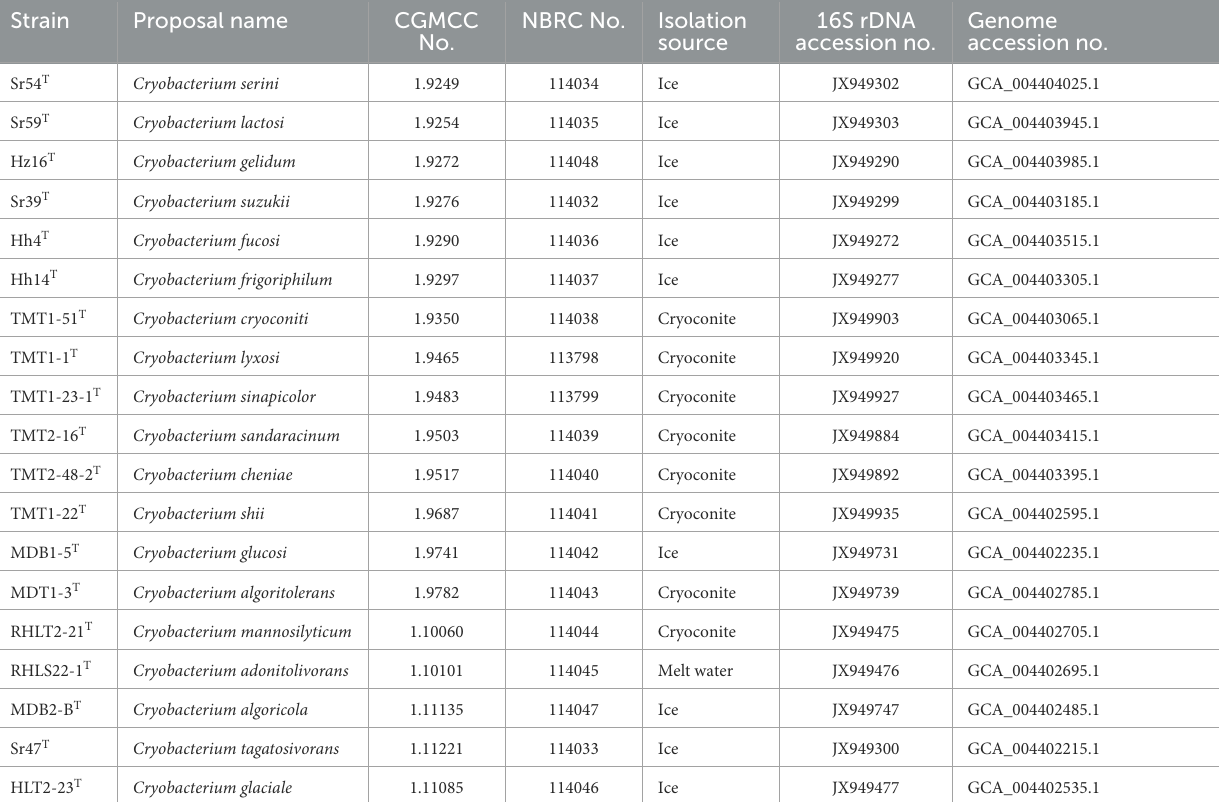
TABLE 1 Nineteen novel Cryobacterium species proposed in this study.